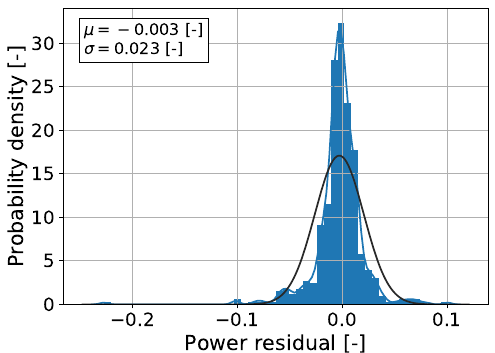
Figure 8. Normalized power estimated by ANN on test set of source data with respect to normalized power simulations.